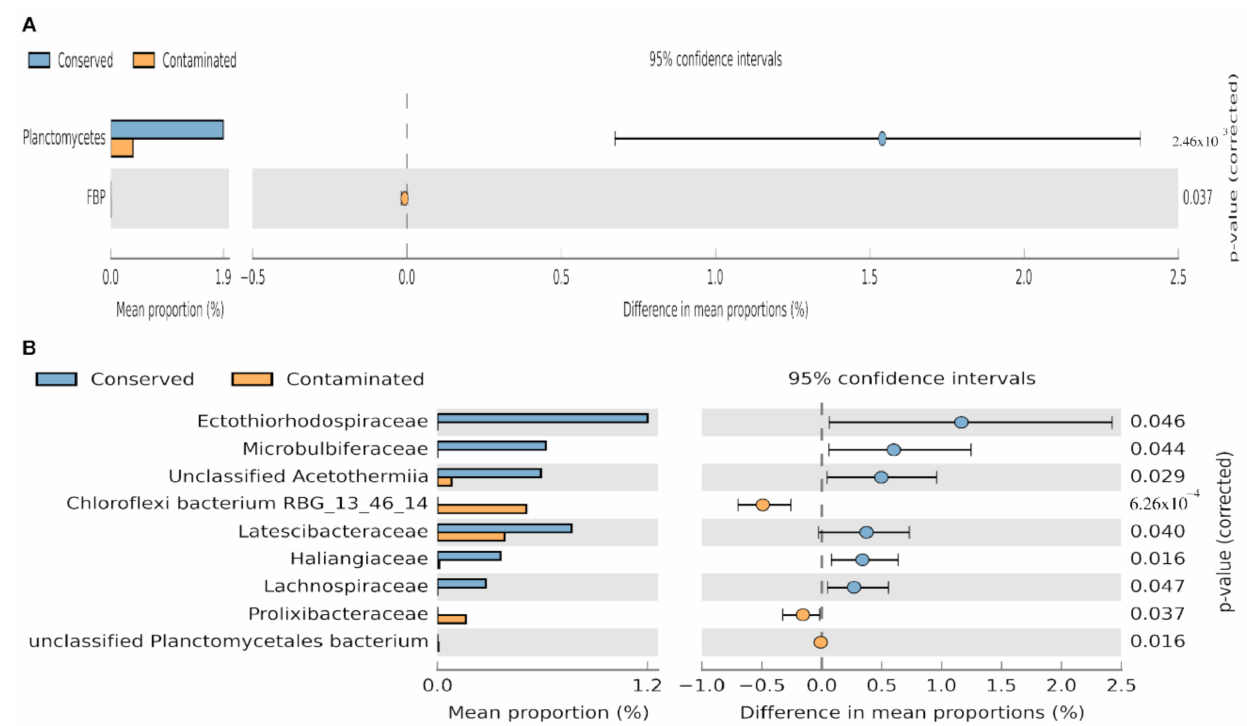
Figure 5. Metataxonomic profile comparisons of differentially phylotypes between conserved sites (Bocas de Dzilam and El Palmar) and contaminated sites (Progreso and Sisal) using Statistical Analysis of Metagenomic Profiles (STAMP) analysis. ( A ): Phylum level. ( B ): Family level. A positive difference between proportions denotes a greater abundance in conserved group (blue bar), whereas a negative difference between proportions shows a greater abundance in contaminated group (orange bar) for the given phyla or family; the standard deviation is shown as a bar in the